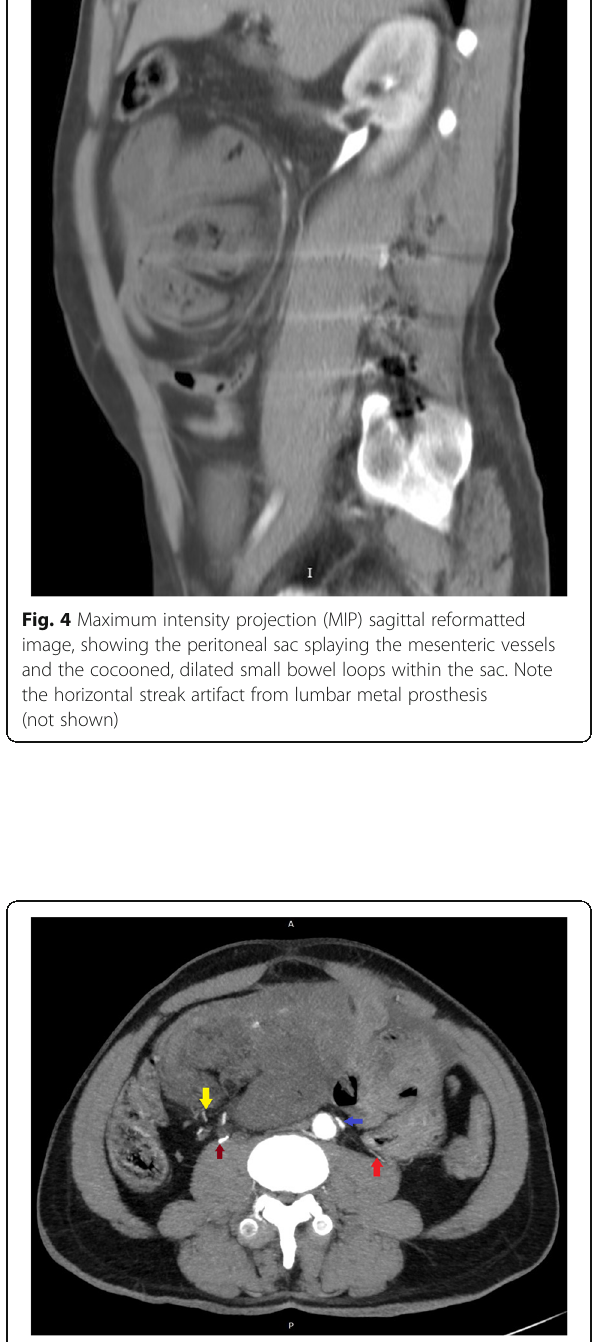
Fig. 5 Maximum intensity projection (MIP) axial image, showing the relation of the peritoneal sac to the inferior mesenteric artery (blue arrow), ascending left colic artery (red arrow), and ileocolic arterial branches (yellow arrow). The right ureter is opacified from prior contrast administration (black